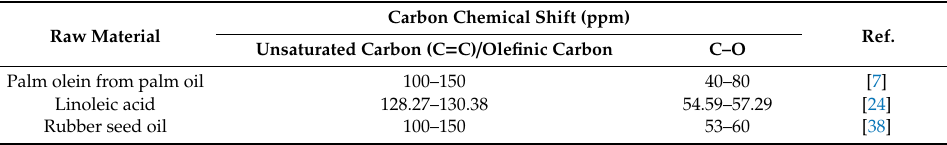
Table 9. 13 C NMR results in an epoxy compound.